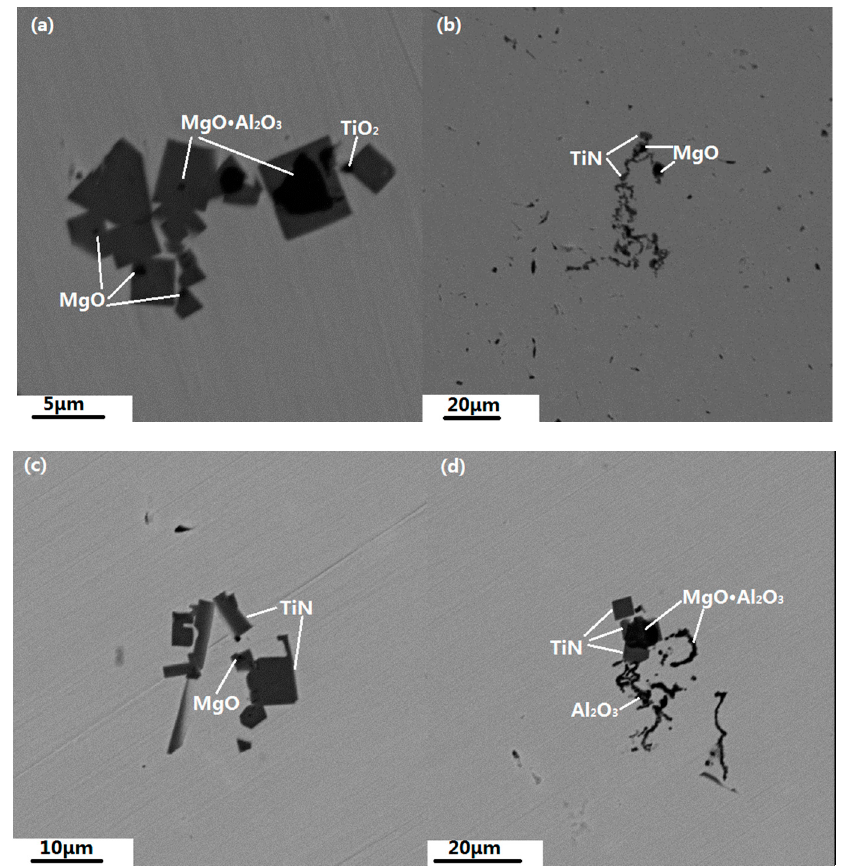
Figure 7. SEM observation for inclusions of industrial samples. ( a , b ) mold floater and ( c , d ) 321 steel. Metals 2019 , 9 , x FOR PEER REVIEW